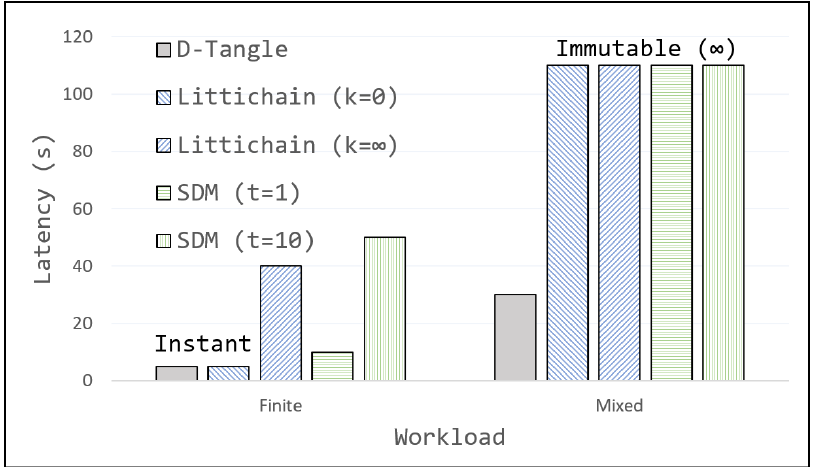
Figure 7. Delete latencies comparison.